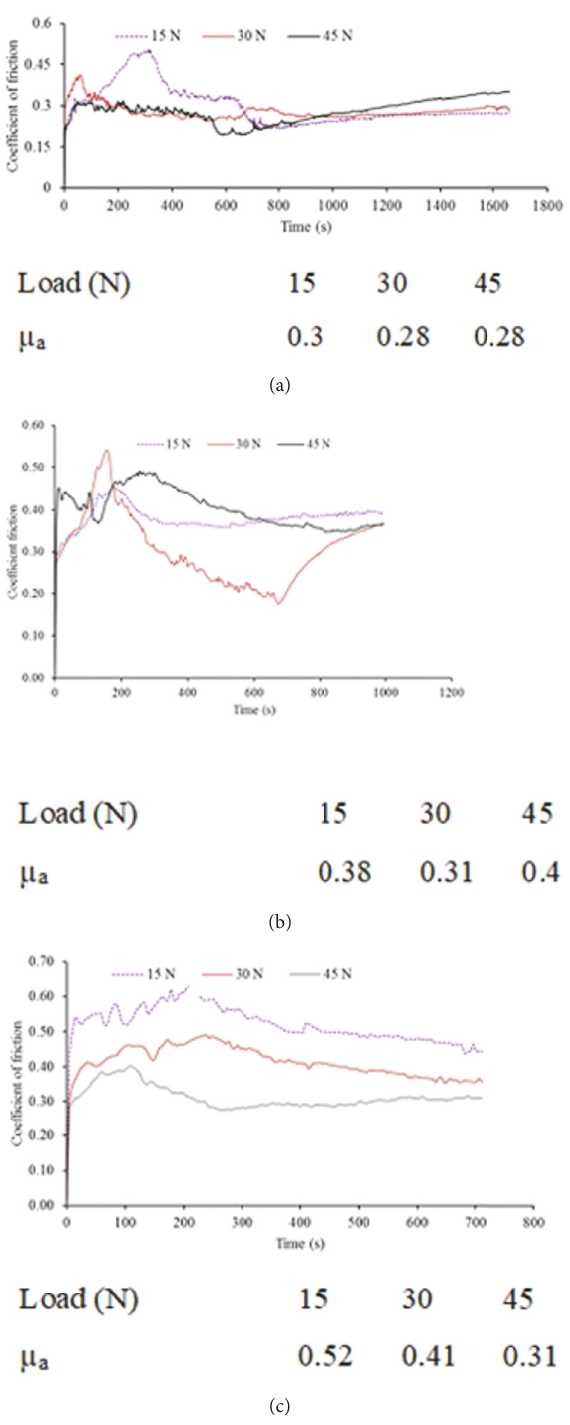
Figure 7: Coefficient of friction plots and average coefficient of friction of CCF/O-MWCNT/E composites at sliding speed (a) 1.5 m.s −1 , (b) 2.5 m.s −1 , and (c) 3.5 m.s −1